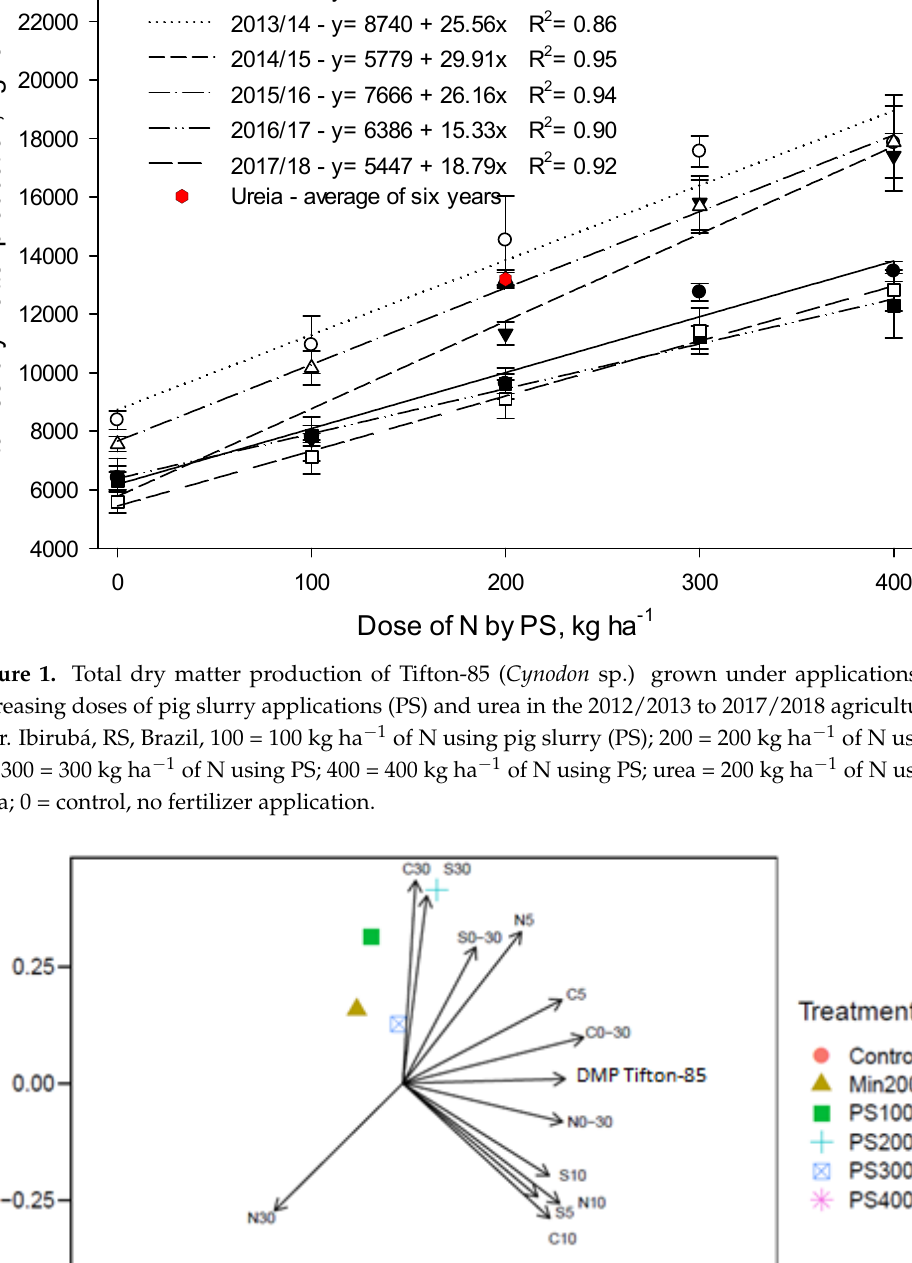
Figure 2. Relationship between principal component 1 (PC1) and principal component 2 (PC2) for dry matter total (DMP) and C, N, and S stocks. C5, N5, and S5 = stocks in the 0–5 m layer; C10, N10, and S10 = stocks in the 5–10 cm layer; C30, N30, and S30 = stocks in the 10–30 cm layer; C0-30, N0-30, and S0-30 = stocks in the 0–30 cm